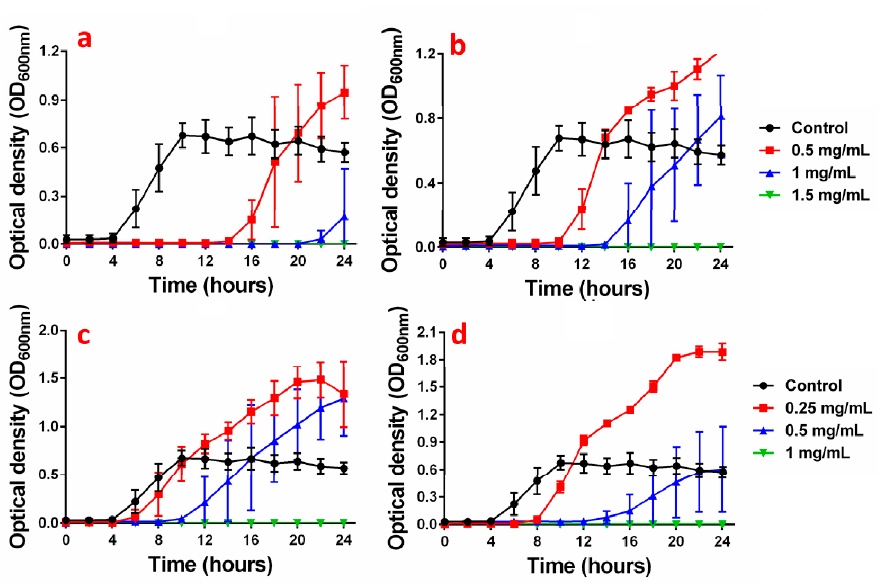
Figure 15. Growth curves of the nanocomposites A with the ratios ( 1 ) ( a ), ( 2 ) ( b ), ( 3 ) ( c ), and ( 4 ) ( d ) at various concentrations against E. coli .